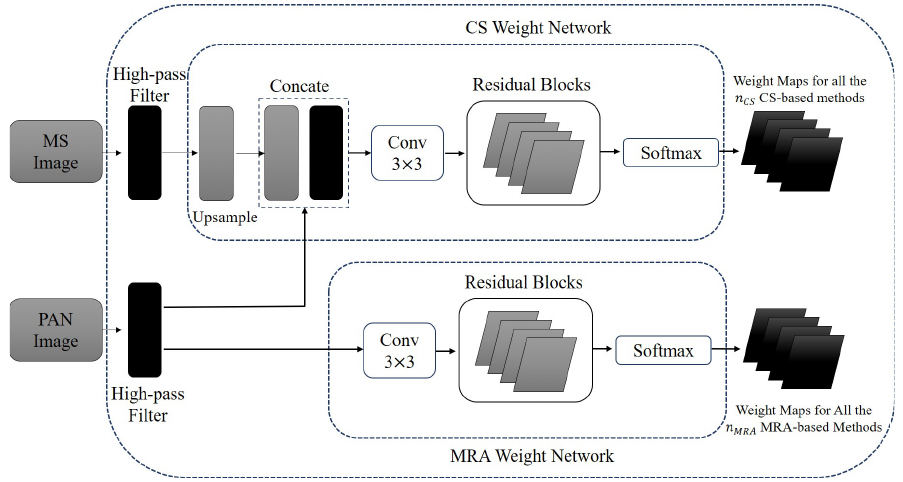
Figure 4. The architecture of proposed PWNet for generating the weight